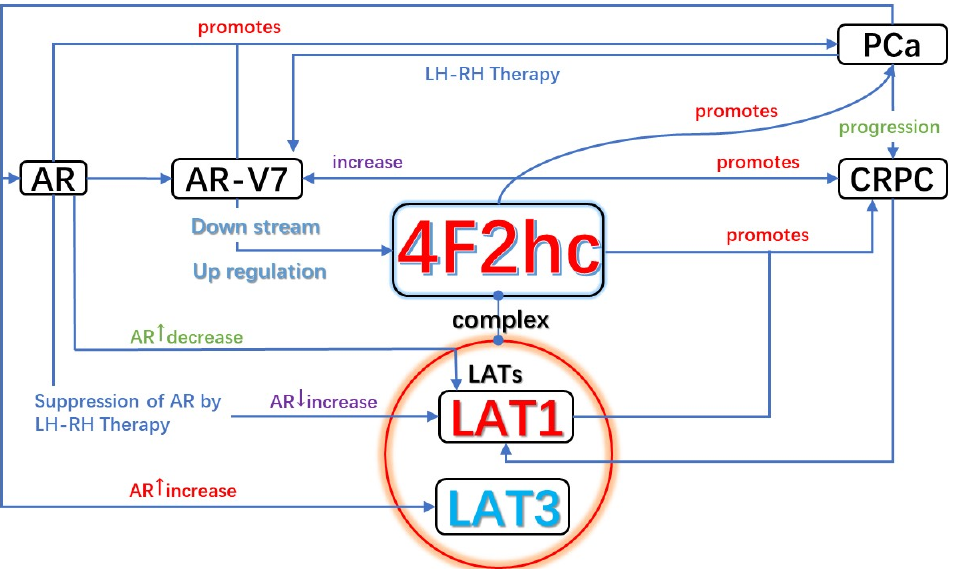
Figure 4. Relationship of LAT1-4F2hc and PCa & CRPC: The relationship between LATx-4F2hc and AR(AR-V7) and different stages of prostate cancer. Reduced androgen receptor signaling and variation of androgen receptors may result in decreased LAT3 expression and higher LAT1 expression.